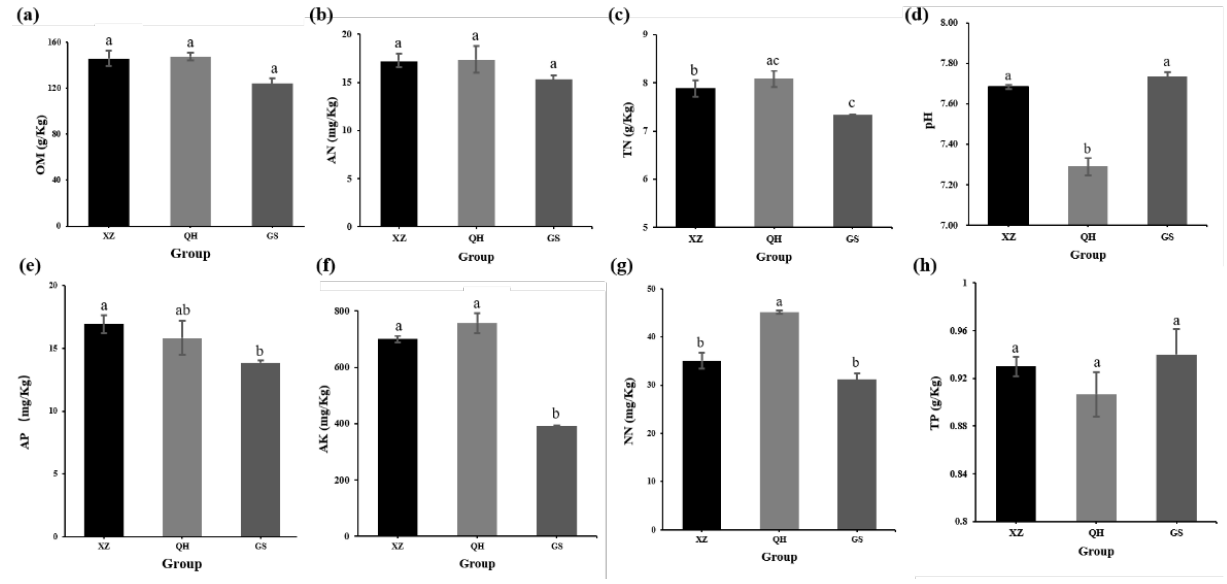
Figure 1. Changes in soil physicochemical properties. Organic matter (OM) ( a ), ammonium nitrate content (AN) ( b ), total nitrogen content (TN) ( c ), soil pH ( d ), available phosphate (AP) ( e ), available kalium (AK) ( f ), nitrate nitrogen content (NN) ( g ), total phosphorus content (TP) ( h ), in the sample of Tibet (Group XZ), Qinghai (Group QH), Gansu (Group GS). Different lowercase letters (a, b, c) indicate a significant difference at p ≤ 0.05.